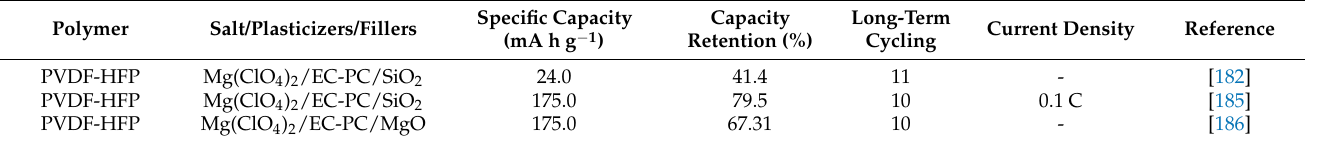
Table 9. Lists of GPEs and their electrochemical performance in